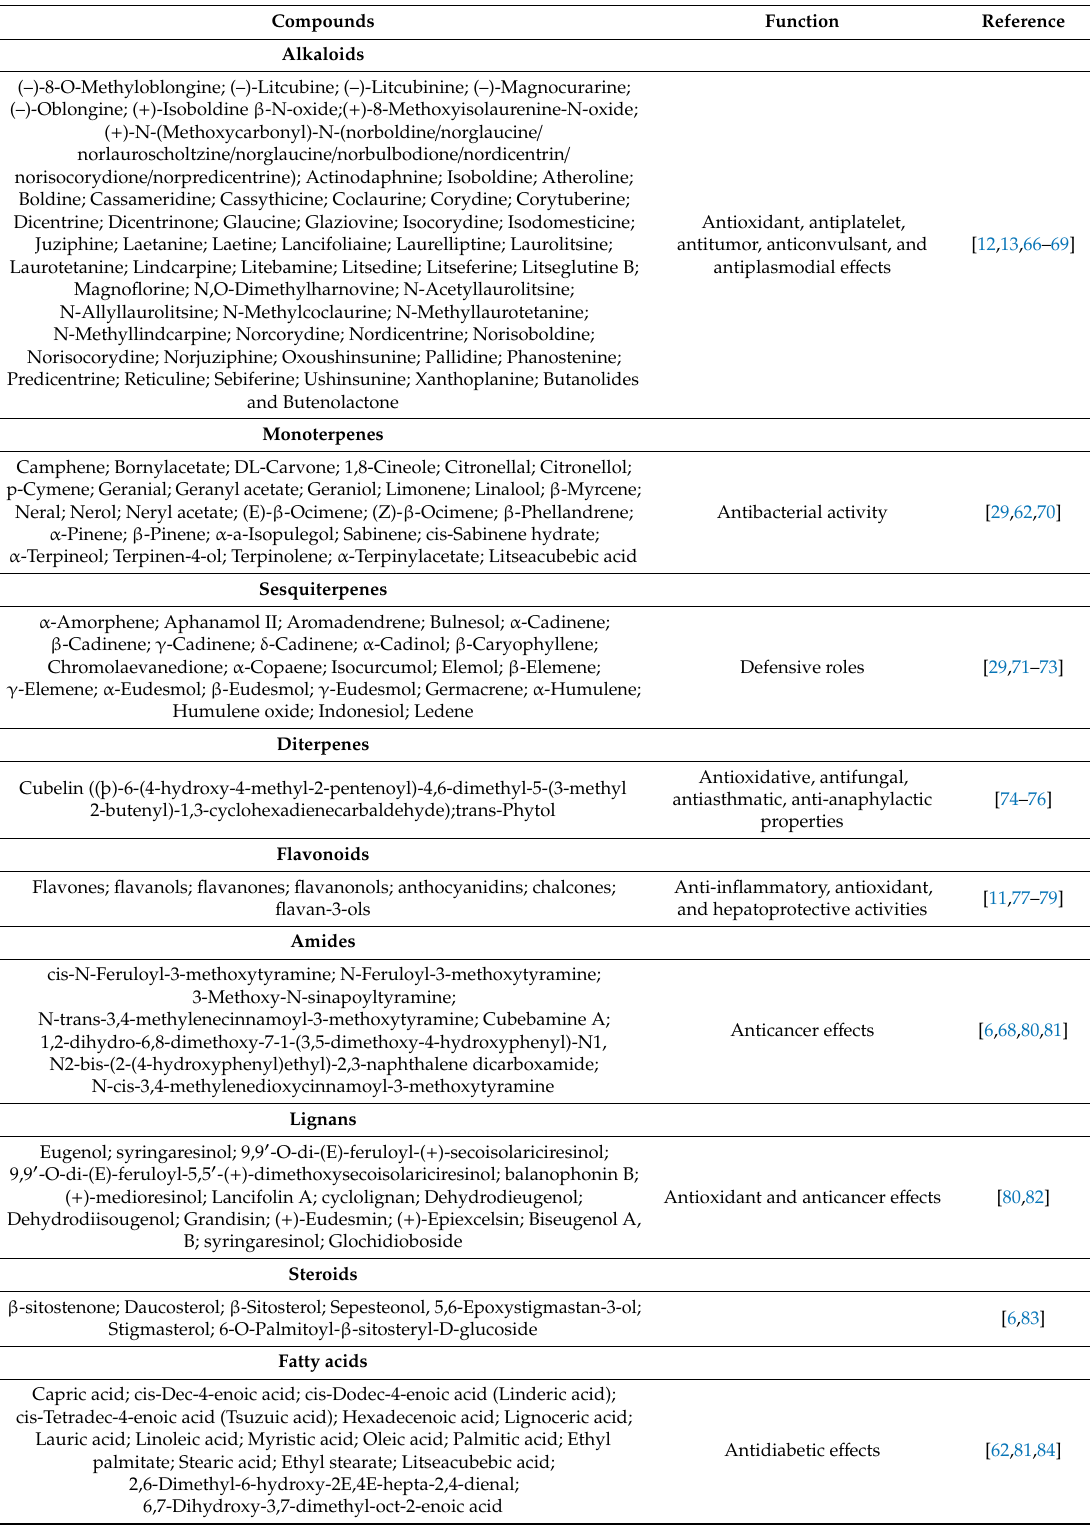
Table 2. Compounds isolated from Litsea cubeba and their